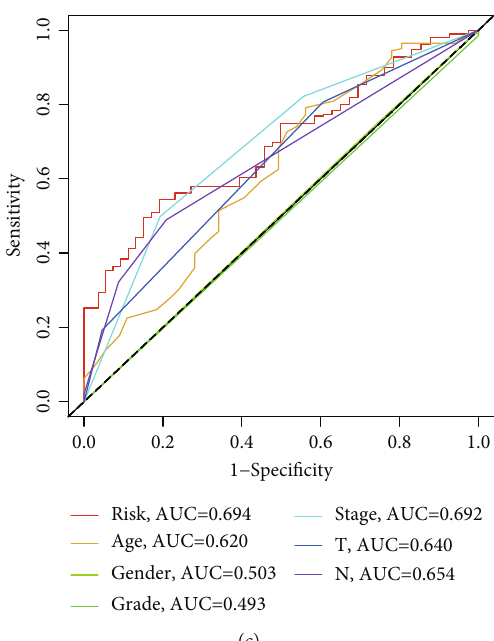
Figure 9: The PPAR signature was an independent prognostic factor for BLCA in the TCGA set. (a) The univariate Cox analysis for evaluating the independent prognostic value of PPAR signature; (b) multivariate Cox analysis for evaluating the independent prognostic value of PPAR signature; (c) ROC curve analyses of the clinical characteristics and risk